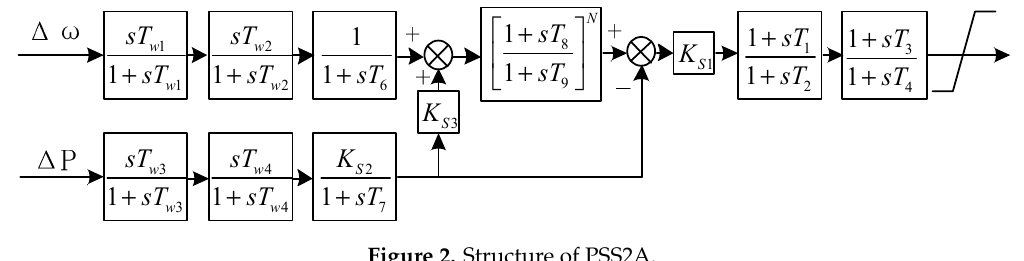
Figure 2. Structure of PSS2A.